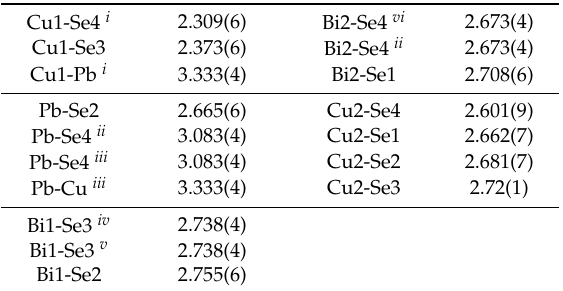
Table 7. Main interatomic distances (Å) for the studied quijarroite